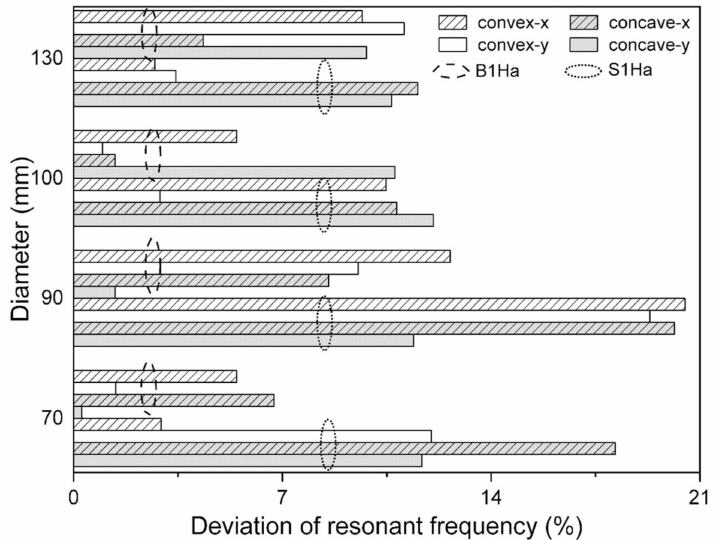
Figure 7. Deviation (%) of f c , under various bent conditions, for the tube diameters as shown in the vertical axis. S1Ha and B1Ha prototypes are